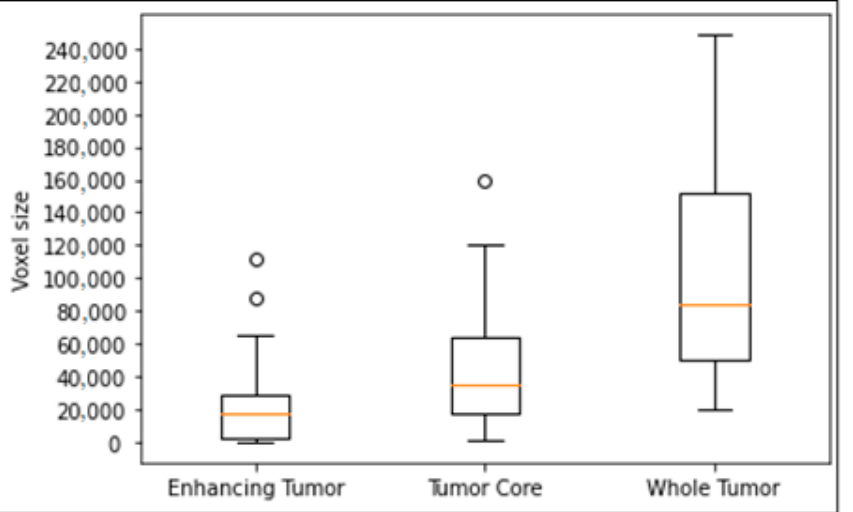
Figure 4. Box plot of tumor volume with different tumor subregions. Outliers in the circle, the box with 25–75% with the orange line of median, and dash bars indicating 0–100% except outliers.